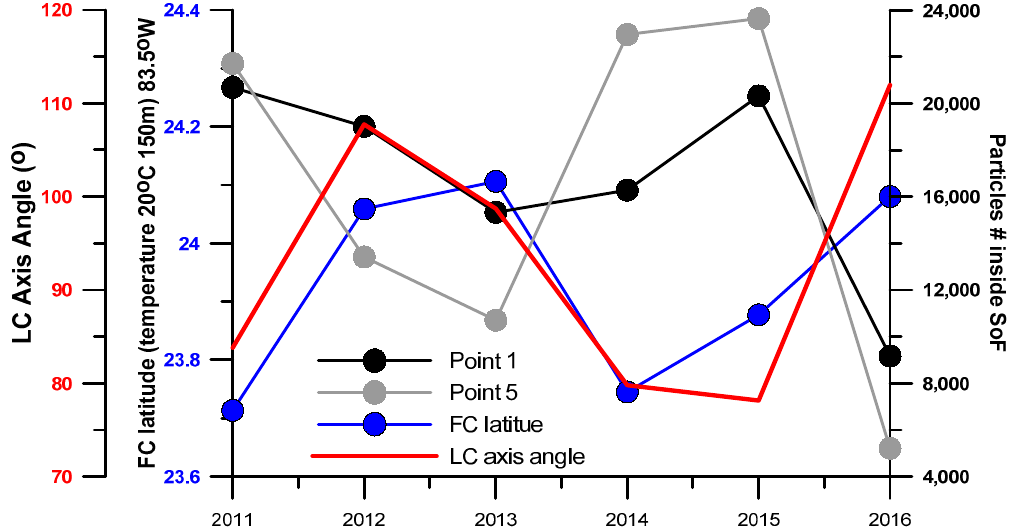
Figure 10. Annual means of the Florida Current (FC; blue line) latitude as derived from the location of the 20 °C temperature contour line at 150 m along the 83.5° W meridian (Section S1, Figure 1a), annual mean values of the Loop Current (LC) axis angle (red line; described in Figure 3) and the total number of oil elements detected inside the Straits of Florida (dashed box in Figure 1b) released at Point 1 (black line) and Point 5 (grey line); see Figure 1b for the location of release points.